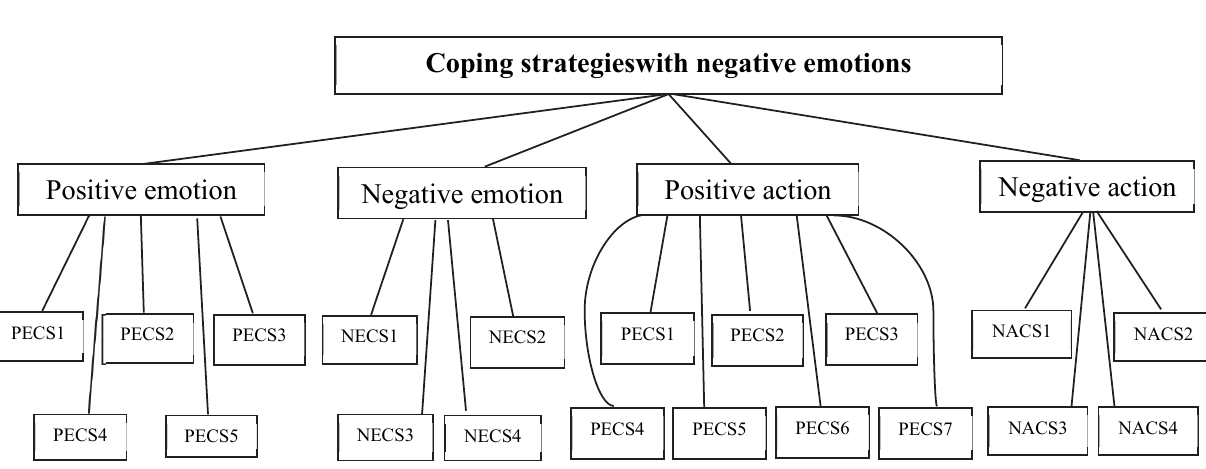
Fig. 1 . Hierarchy of coping strategies with negative